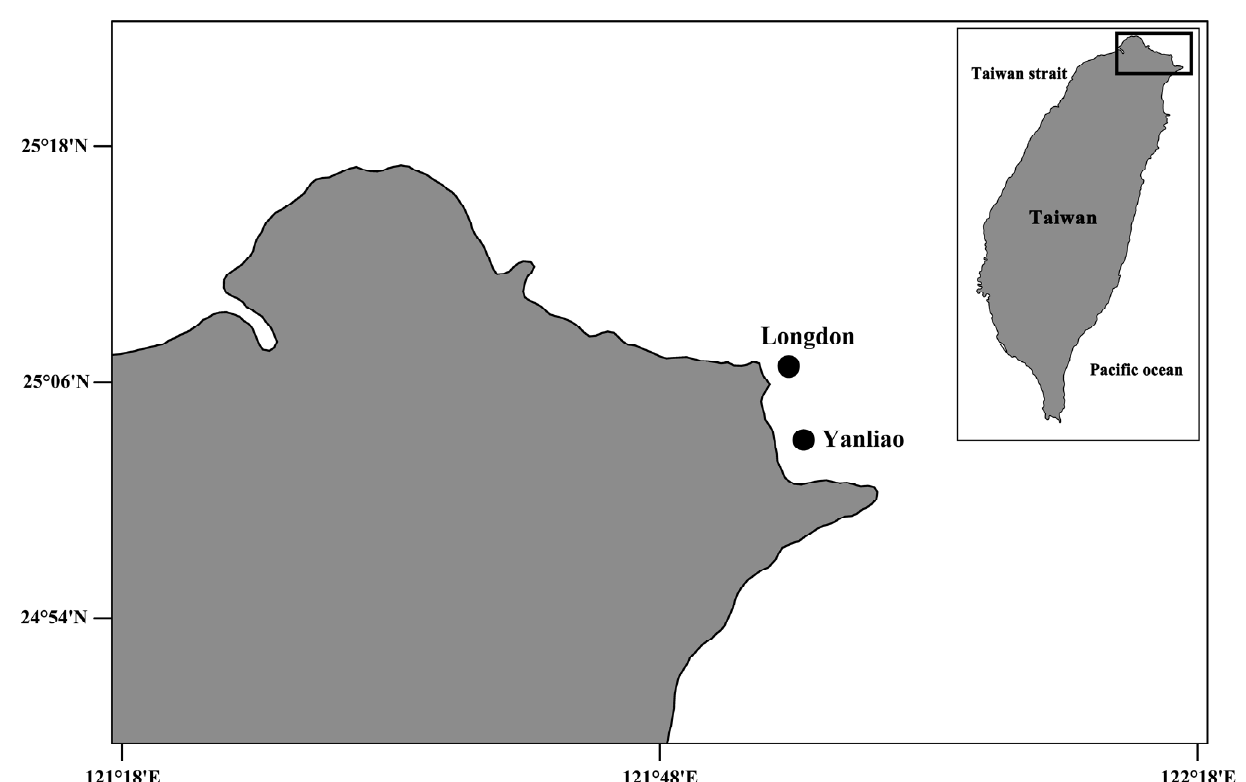
Figure 1. Map of Taiwan showing the type locality of Xarifia yanliaoensis sp. nov. and Xarifia magnifica sp. nov.